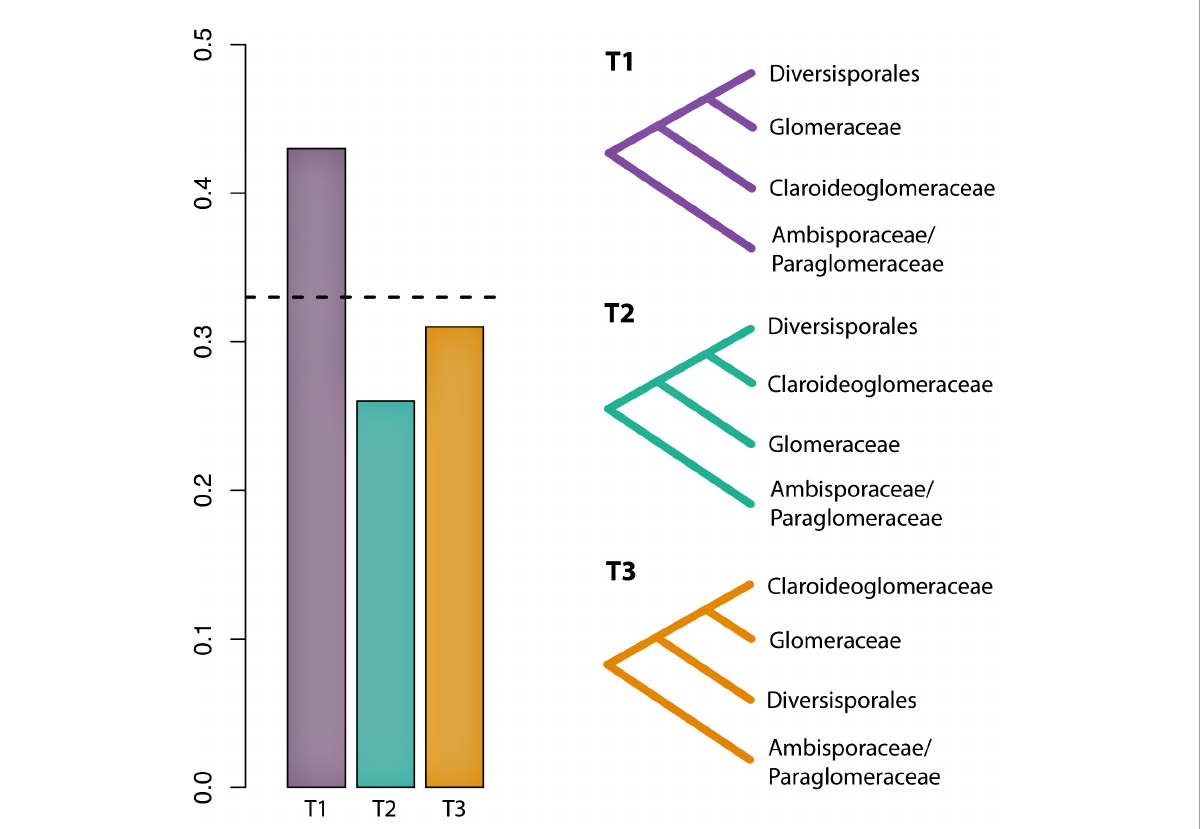
FIGURE2 Evaluation of support among 1260 individual gene trees for alternative hypotheses of the phylogenetic placement of Claroideoglomeraceae. Bar graphs represent the gene tree quartet frequencies for three possible branching orders. The dashed horizontal line indicates the expectation of a hard polytomy.